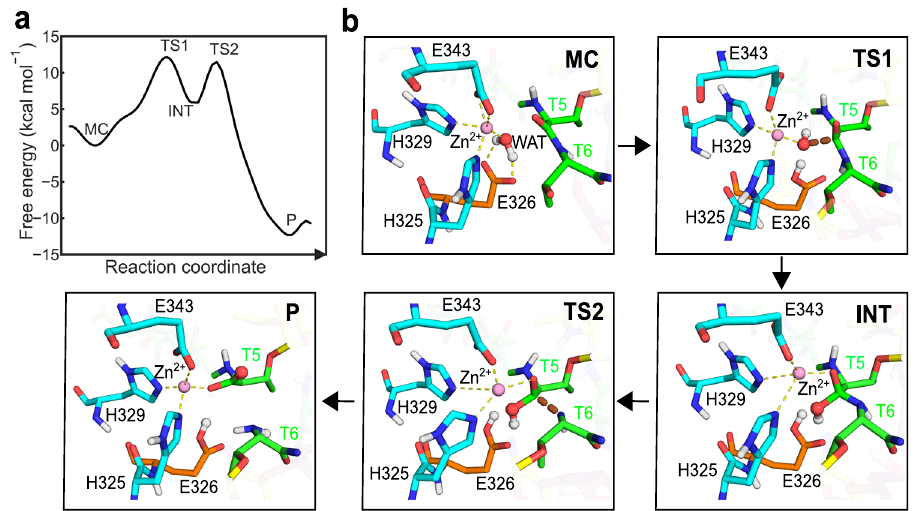
Fig. 5| Reactionmechanism ofAM0627 obtainedfromQM/MM metadynamics simulations. a Reaction free energy pro fi le. b Representative structures of the Michaelis complex (MC), the transition state of the fi rst reaction step (TS1), the reaction intermediate (INT), the transition state of the second step (TS2), and the